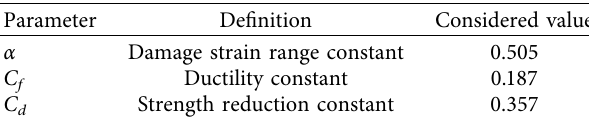
Table 1: Fatigue